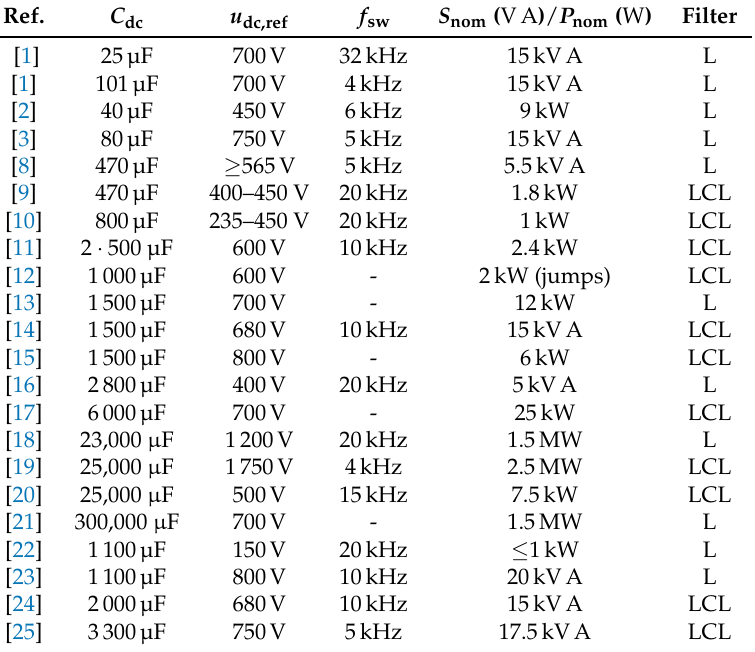
Table 1. Exemplary literature overview of used sizes of dc-link